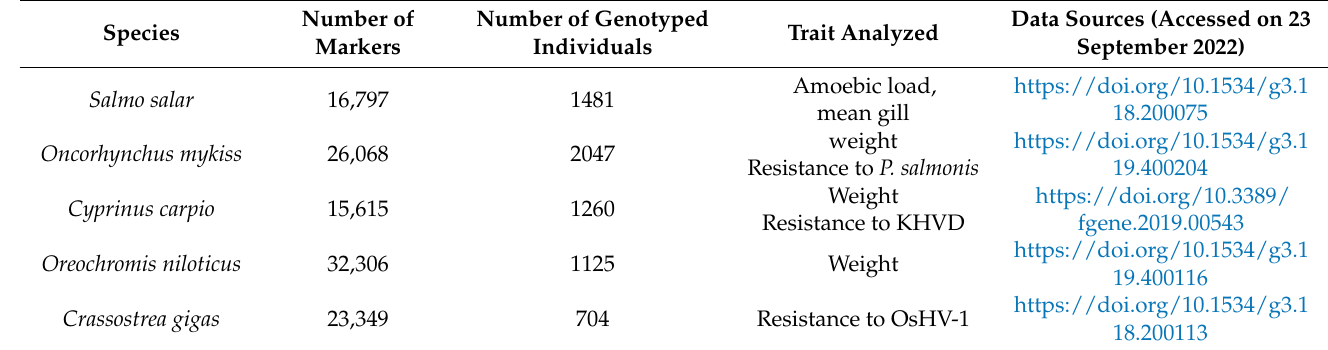
Table 1. Datasets used in this